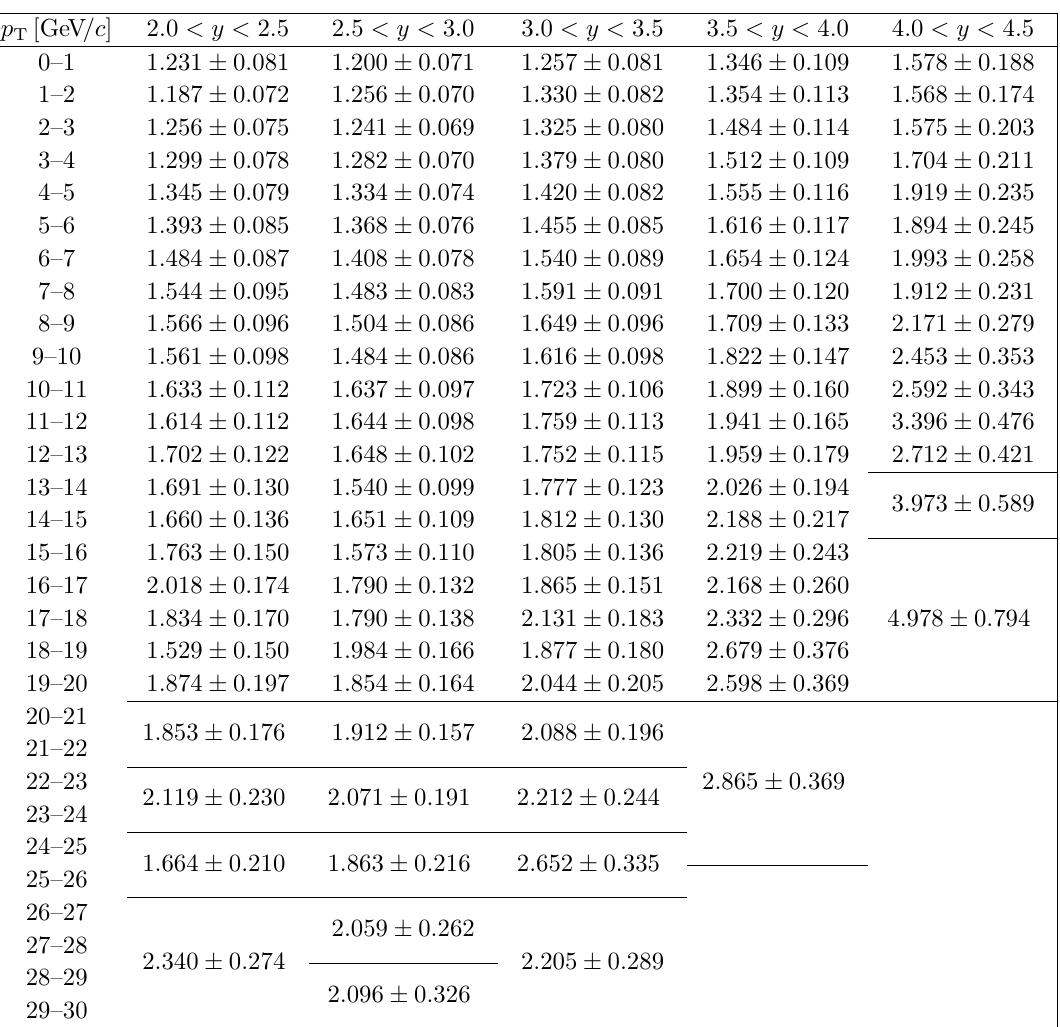
Table 5 . The cross-section ratios between 13 TeV and 8 TeV in di(cid:11)erent bins of p T and y for (cid:7) (1 S